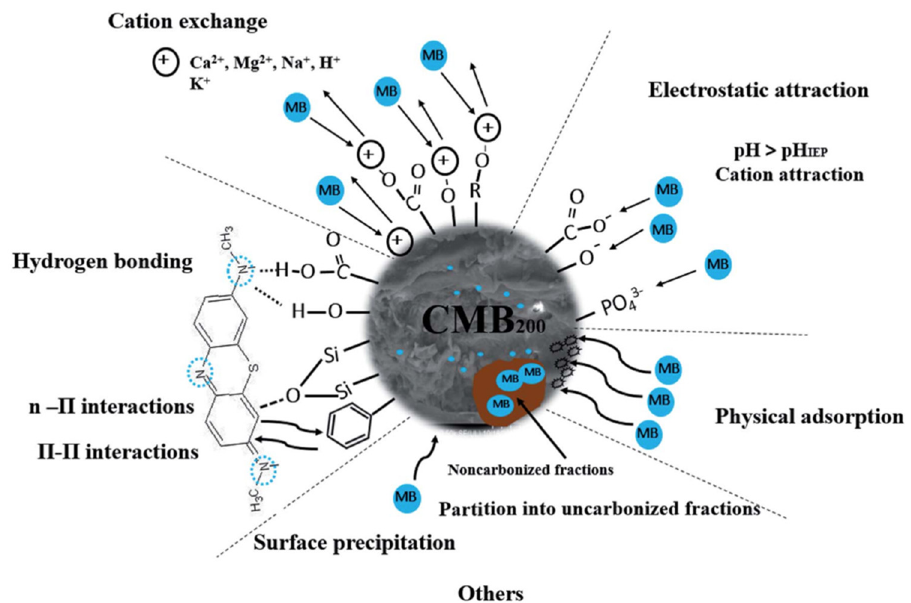
Figure 2. Interaction mechanisms involving adsorption in the biochar-MB system. Reproduced with permission from [28]. (Copyright reserved Royal Society of Chemistry, 2018).